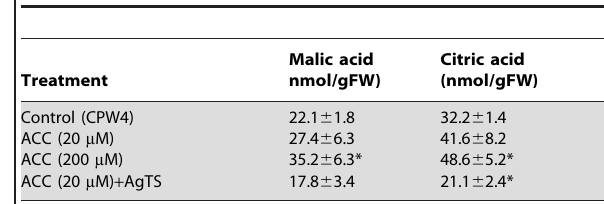
Table 1. Malic and citric acid contents of 8 daa tomato fruit slices.